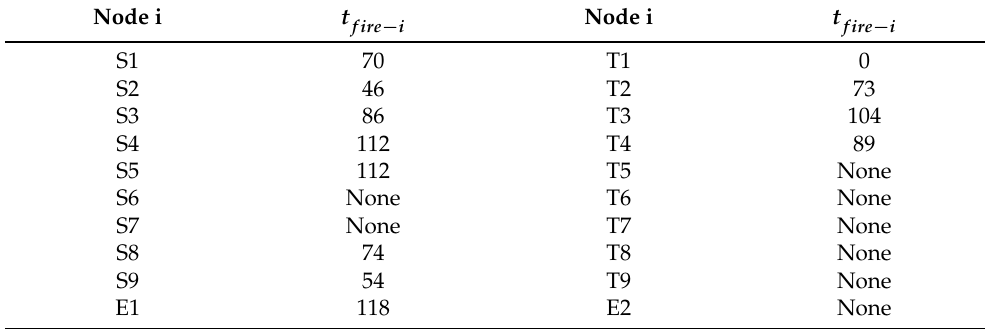
Table 7. Time used for each node to change from a safe state to danger in case of sudden fire at T1. Node i t Node i t fire − i fire − i S1 70 T1 0 S2 46 T2 73 S3 86 T3 104 S4 112 T4 89 S5 112 T5 None S6 None T6 None S7 None T7 None S8 74 T8 None S9 54 T9 None E1 118 E2